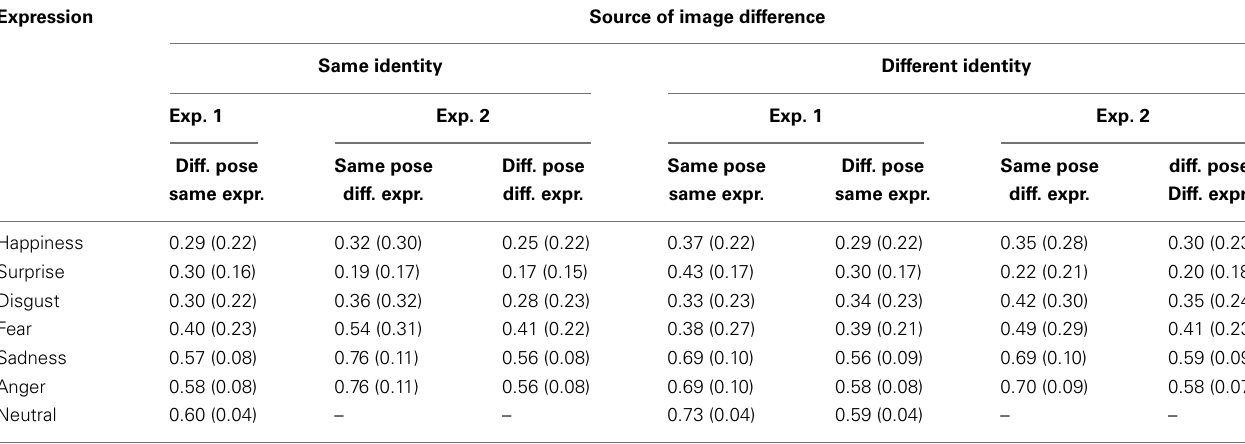
Table 1 | Mean similarity scores between paired images.